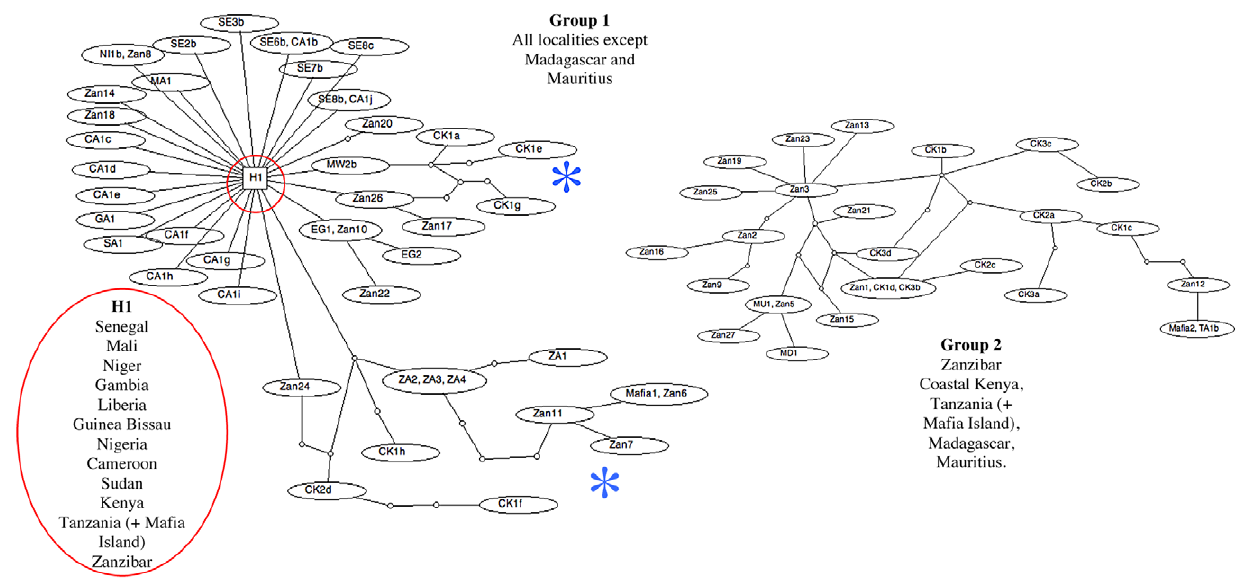
Figure 1. Minimum spanning TCS networks incorporating all the cox 1 haplotypes analyzed in this study. Each line between haplotypes represents a single bp change and small circles between lines represent unsampled or extinct haplotypes. The network forms 2 distinct groups of haplotypes that cannot be linked. Group 1 is a simple network containing the main land African samples and a few of the Indian Ocean Island samples. The majority of the samples are closely clustered around the main haplotype (H1) by separate single links representing a single polymorphic position. There are 2 longer branches, ‘‘blue star’’, leading off from the main cluster to form networks between Zanzibar, Coastal Kenya, Tanzania ( + Mafia) and Zambian samples. H1 represents samples from 29 out of the 43 separate localities and represents 1574 out of the 1978 sequences analyzed (see figure 2 for the list of haplotype codes that represent H1). Group 2 forms a more complicated network containing the majority of the samples from the Indian Ocean Islands and samples from the closely located areas of Coastal Kenya and Tanzania. Identical haplotypes are grouped in the same oval.